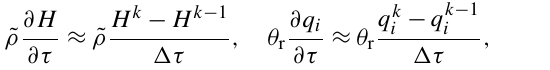
rate ε BG to 0. We model buoyancy using the Boussinesq